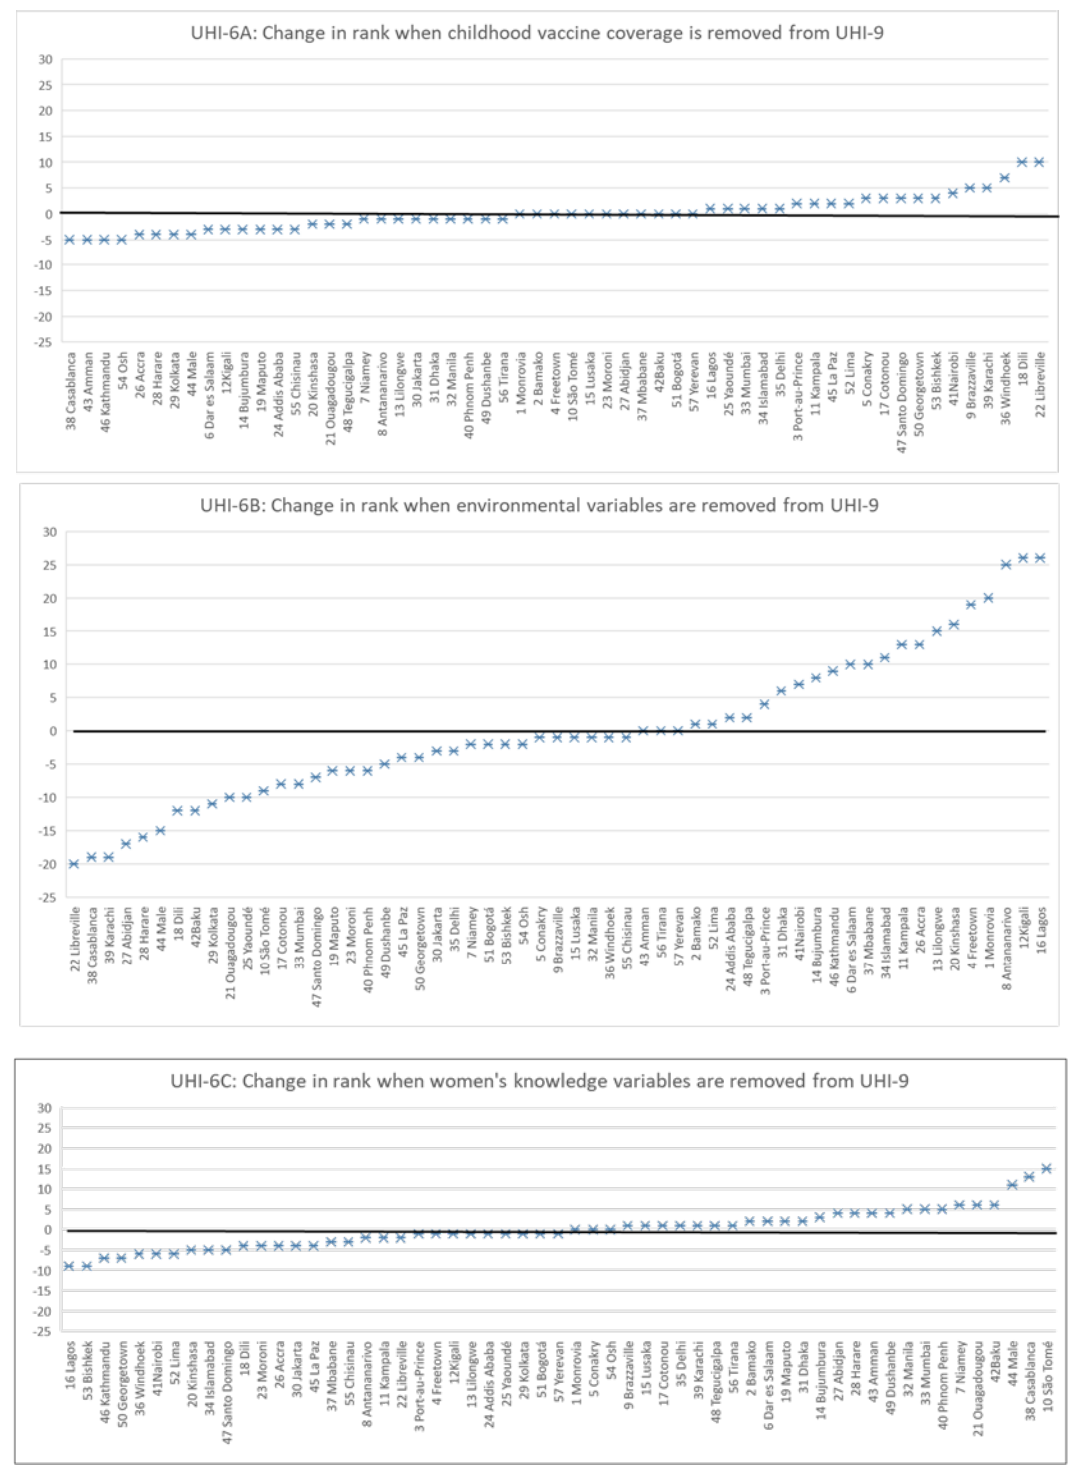
Figure 2. Comparison of changes in rankings of cities with different groupings of indicators.